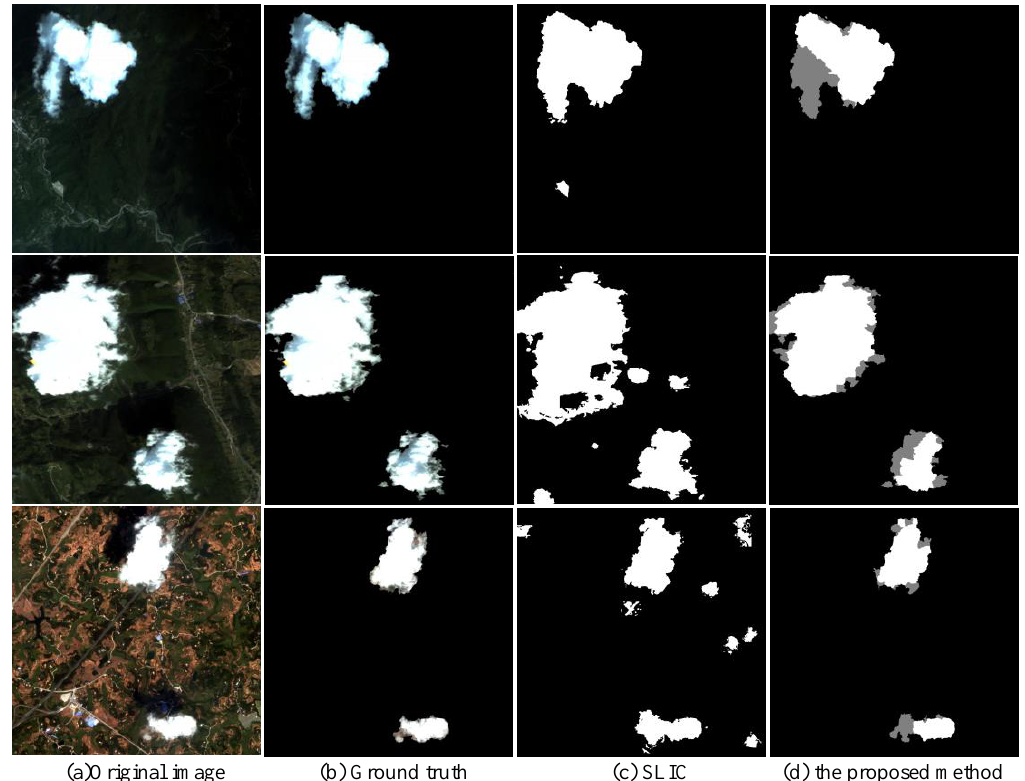
Figure 5. Visual comparisons of different methods on cloud